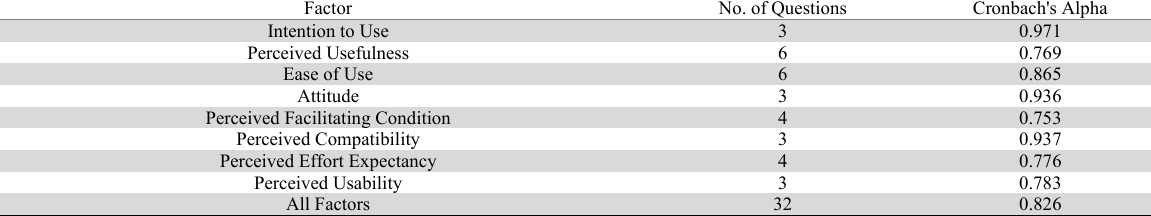
Internal Consistency of the Used Questionnaire